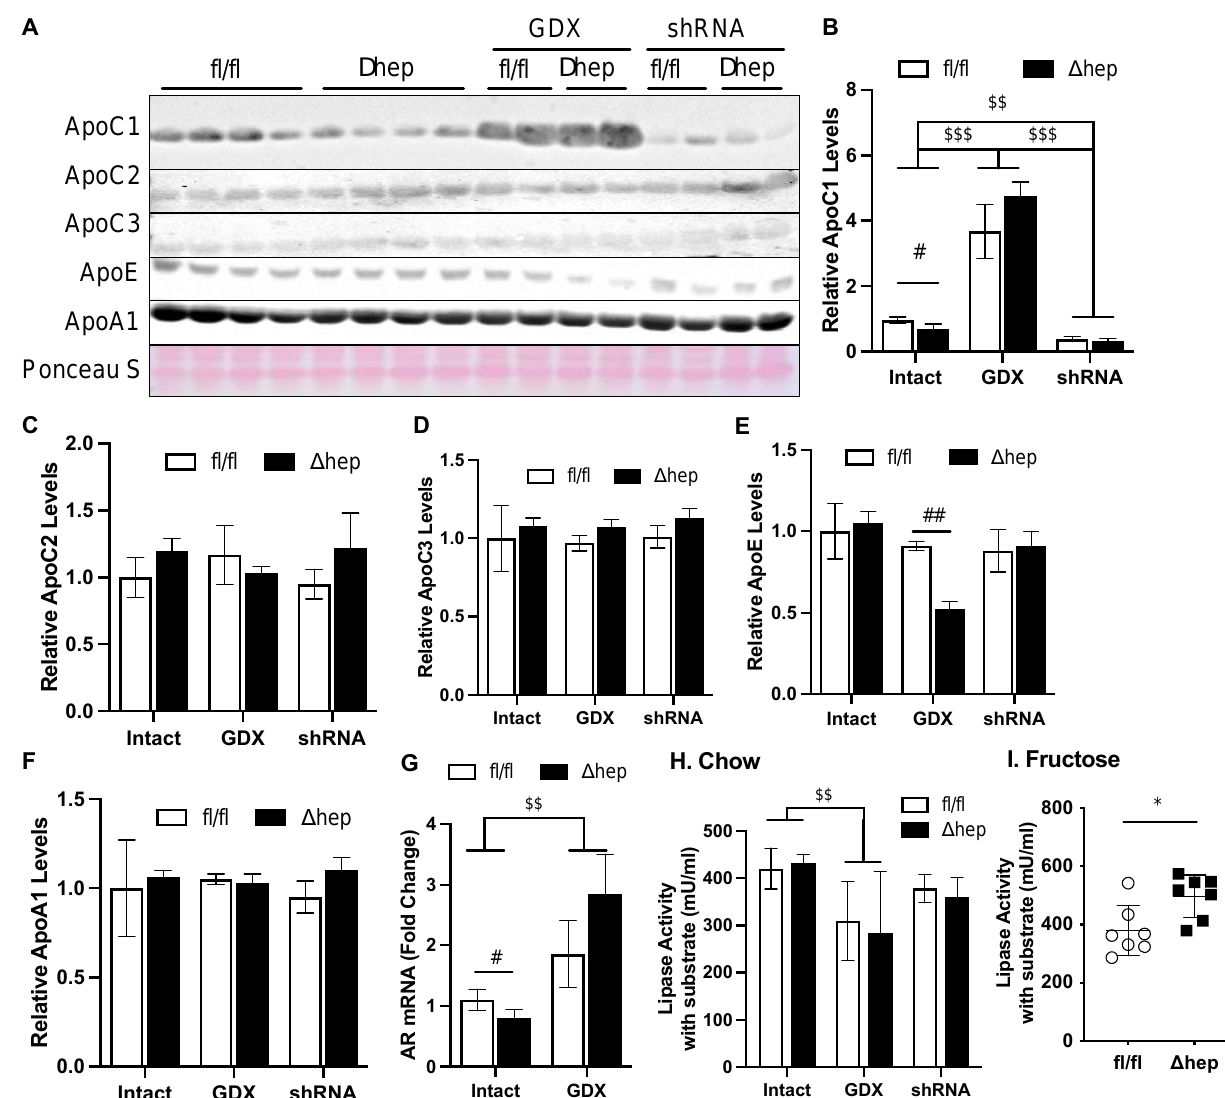
Figure 7. Effect of hepatic deletion of SHP on lipoprotein lipase activities. ( A – F ) Plasma ApoC1, ApoC2, ApoC3, ApoE, and ApoA1 levels were determined with immunoblotting and blot quantifications. ( G ) Liver mRNA levels of AR in intact or GDX fl/fl and SHP ∆ hep mice. ( H , I ) Plasma from chow ( H ) and fructose ( I ) fed mice was used to evaluate lipoprotein lipase activity. Data shown are mean ± SD ( n = 6~8/group), # p < 0.05 and ## p < 0.01 for genotype effect, and $$ p < 0.01 and $$$ p < 0.001 for treatment effects (2-way ANOVA). * p < 0.05 ( t